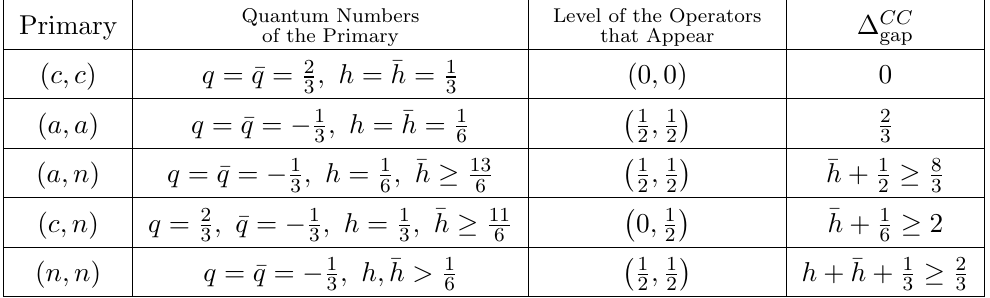
Table 4. The allowed = (2 ; 2) multiplets that can appear in the chiral-chiral channel of the N (cid:22) (cid:30) (cid:30) 1 (cid:30) (cid:30) 1 four-point function in the c = 3 case. Here c; a; n stands for chiral, antichiral, and (cid:0) 1 (cid:0) 1 h 3 3 3 3 i ; 1 non-BPS, respectively. Note that the level ( 1 ) descendant of an ( a; a ) primary minimizes the 2 2 (cid:1) CC , which is de(cid:12)ned as the gap in the scaling dimensions of the operator that appears in the OPE gap and of the ( c; c ) primary. We omitted the conjugates (i.e. ( n; a ) and ( n; c )) of the 1 in the above